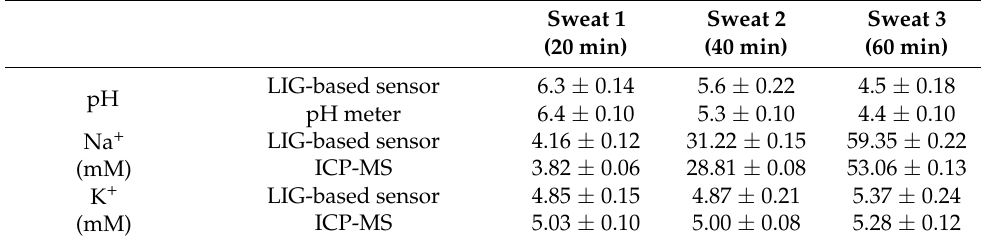
Figure 5. On-body real-time monitoring of sweat during stationary cycling: ( a ) photograph of a LIG-based sensor attached to the forearm of a subject for continuous monitoring of pH, Na + , and K + levels in sweat, and the data were collected with a flexible, printed circuit board (FPCB) and then transmitted wirelessly to the smartphone-based application via Bluetooth; ( b ) photograph of the FPCB, which consists of (i) microcontroller, (ii) Bluetooth module, (iii) power switch and charging USB, (iv) sensor connector, (v) power management module, and (vi) lithium-ion battery; ( c ) enlarged photograph of the LIG-based sensor attached to the forearm of a human subject; ( d ) photograph of the developed Android application; ( e ) block diagram of FPCB showing the signal transduction from the LIG-based sensor to the custom-developed mobile application; ( f ) real-time sweat analysis results of pH, Na + , and K + concentrations using the integrated wearable sensing system. Table 1. Comparison of the sensing performance using the LIG-based sensors and conventional gold standard techniques. Sweat samples 1–3 were collected at 20, 40, and 60 min during on-body tests,